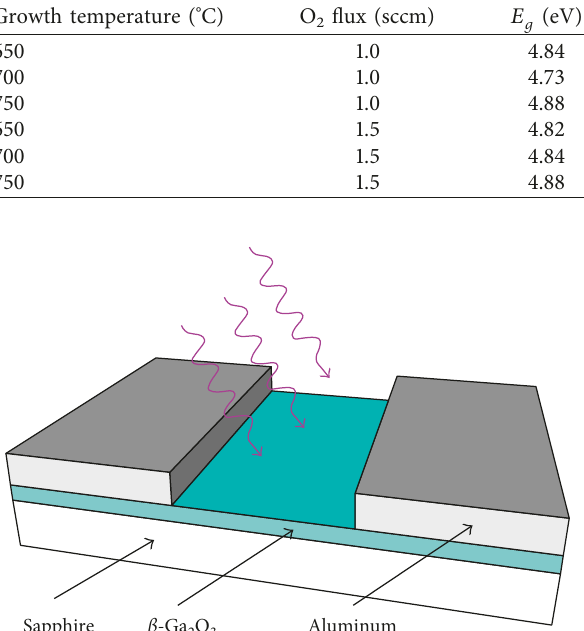
Figure 5: UV-Vis spectra of sapphire substrate (circles) and β -Ga 2 O 3 thin films grown at 700 ° C with RF plasma power of 200 and 300W (squares and triangles) and at 750 ° C at the same powers (diamonds and crosses).